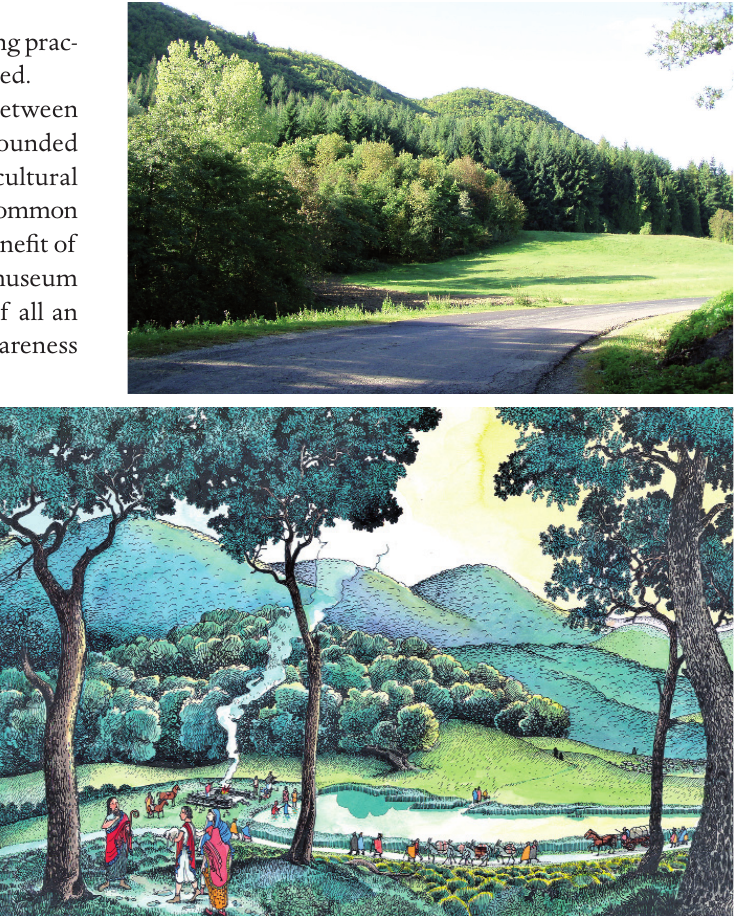
Figure 2. Transformation of the Lago Bracciano area. The Lago Bracciano area today (top) and in the Etruscan Age (bottom). Reconstruction by Riccardo Merlo, exhibition Mans and Gods of the Mountains , Modena, 2006 (courtesy of Museo Civico Archeologico, Modena). Figure 3 (below). A guided tour of the Lago Bracciano area, together with a witness of the events of the Second World